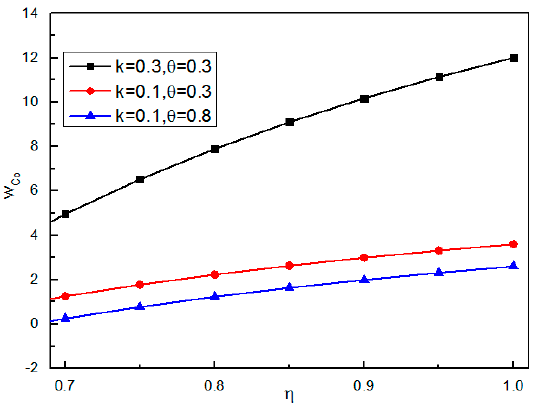
Figure 3. Variation of w Co with η for different values of k and θ .